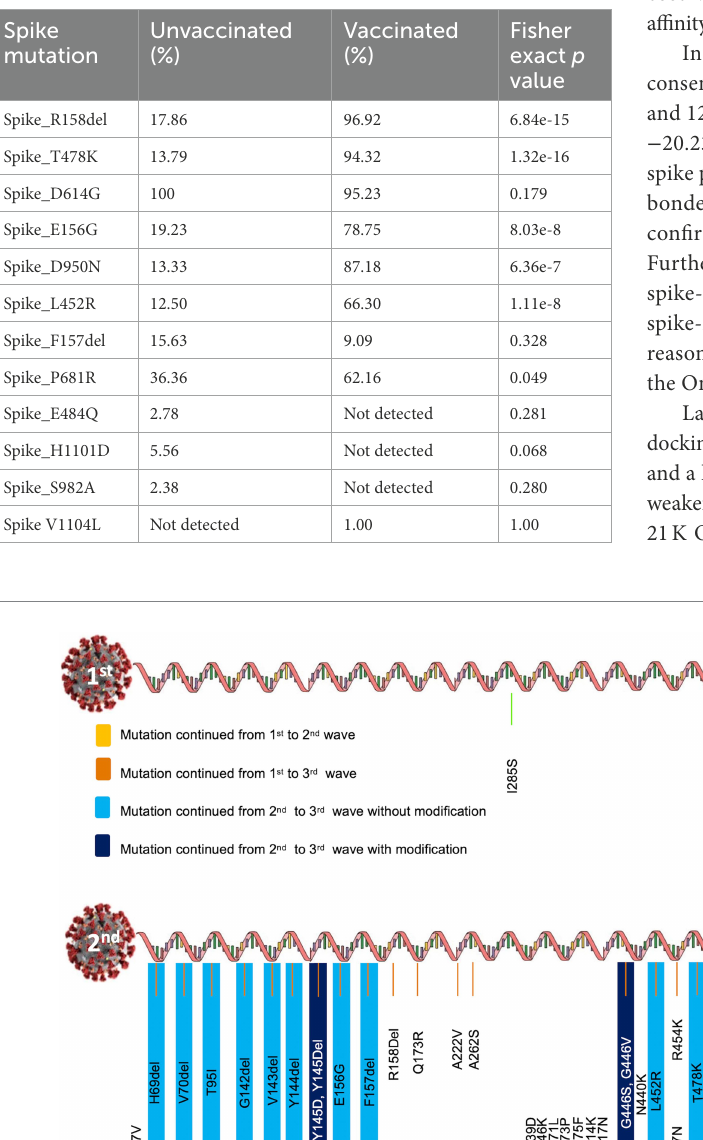
Vaccinated Fisher (%) exact p